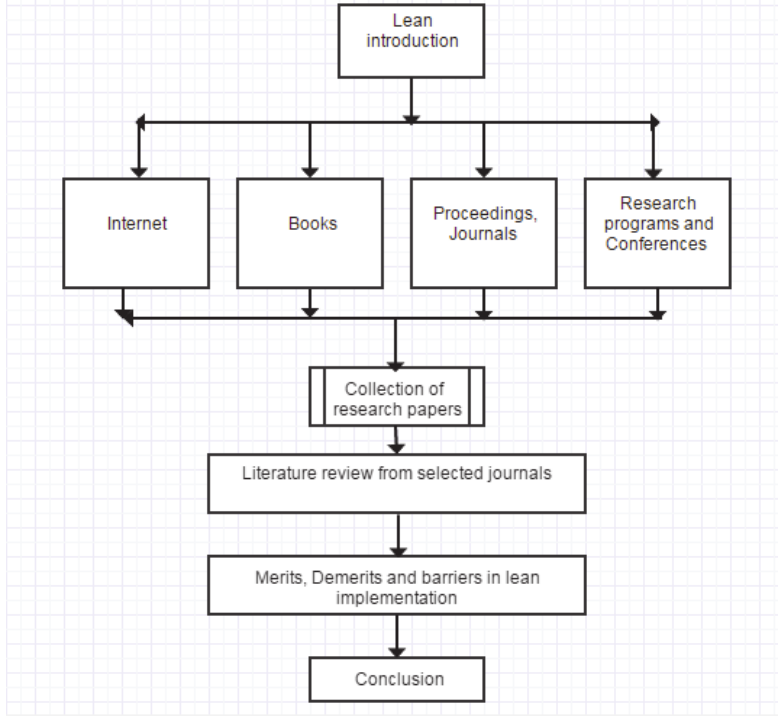
Fig. 2. Lean Manufacturing cycle for collected literature